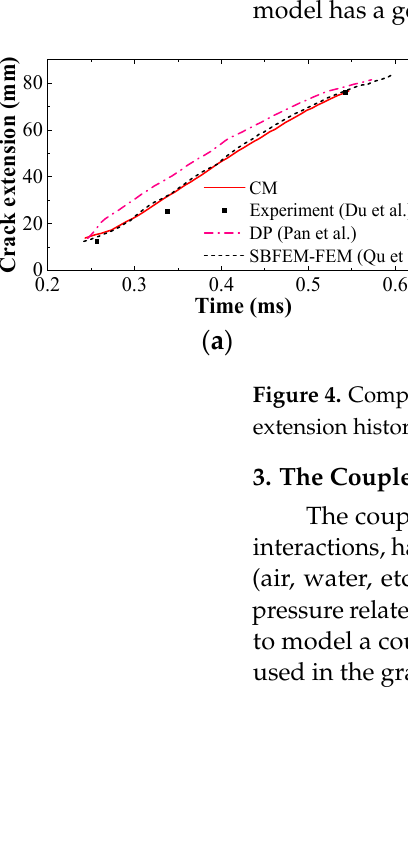
Figure 4. Comparison between numerical simulation and existing research results [38–40]. ( a ) Crack extension history; ( b ) load-vertical displacement curves at the loading point.